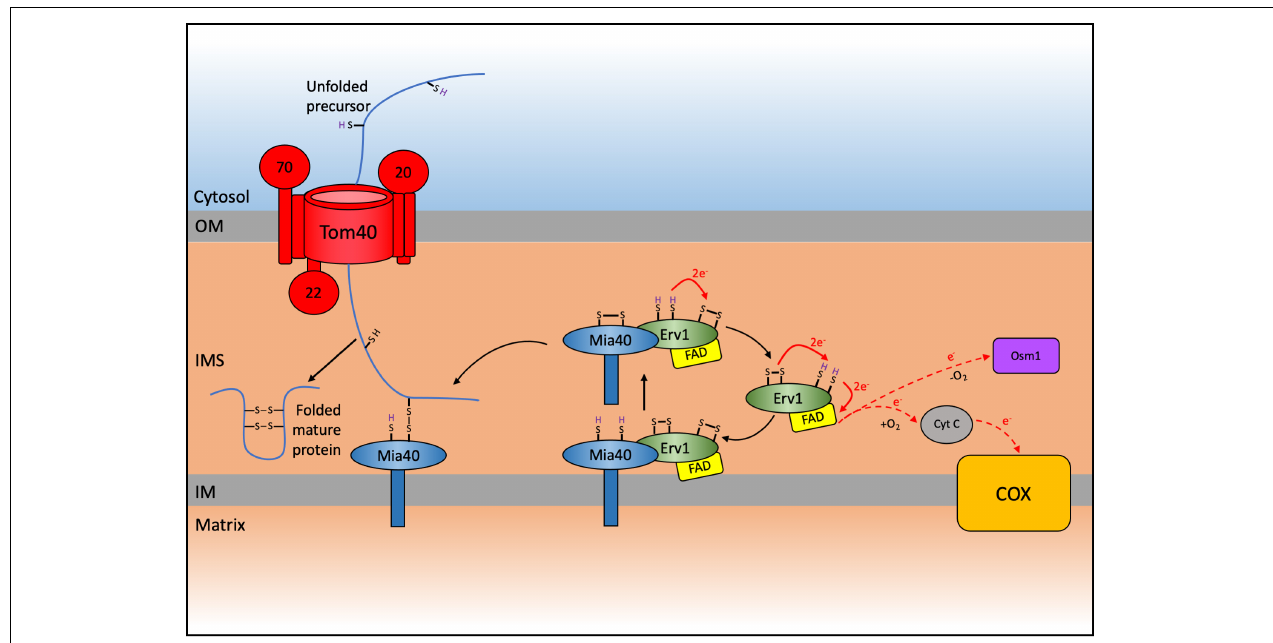
FIGURE 2 | Schematic representation of the mitochondrial import and assembly (MIA) pathway in yeast. A subset of proteins destined for the intermembrane space (IMS) are imported via the MIA pathway which results in the oxidative folding of these substrates thereby trapping them in the IMS. Nuclear encoded CX n C motif containing proteins are first imported through the TOM complex. These proteins contain an IMS-Targeting signal (ITS) that interacts with Mia40 resulting in the oxidation and subsequent folding of the substrate protein, thereby trapping it in the IMS. This interaction leaves Mia40 in a reduced state that must be reoxidized to allow it to further oxidize incoming substrates. This reoxidation is facilitated by interaction with Erv1 with subsequent electron transfer to cytochrome c and complex IV (COX) of the respiratory chain in aerobic conditions, or onto Osm1 in anaerobic conditions. The system varies in humans, where CHCHD4/MIA40 is a soluble IMS protein that interacts with membrane bound AIFM1 and with ALR/GFER/ERV1 (Reinhardt et al.,